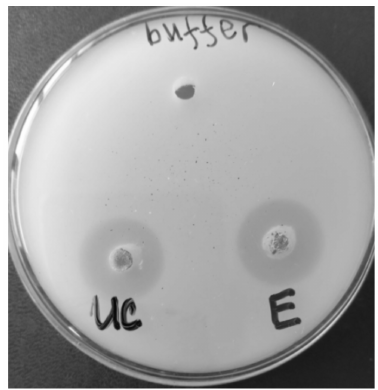
Figure 2. Clear halos were observed in agar plates containing 0.1% PCL (MW 14,000) when 50 µ L containing 145 U of UC (ultraconcentrate) or E (pure enzyme) were incubated in the holes at 55 ◦ C for 24 h. Buffer was used as a